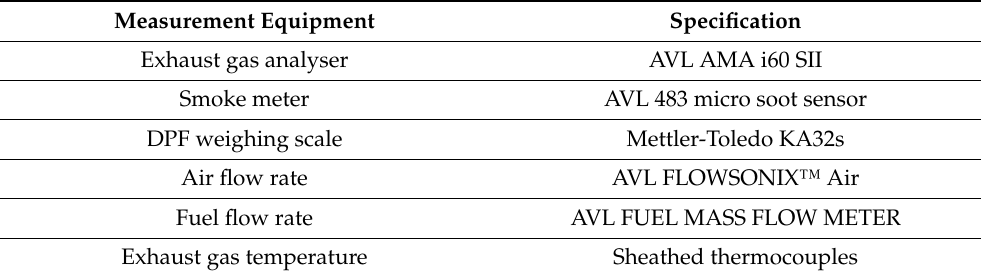
Table 3. Measurement facility